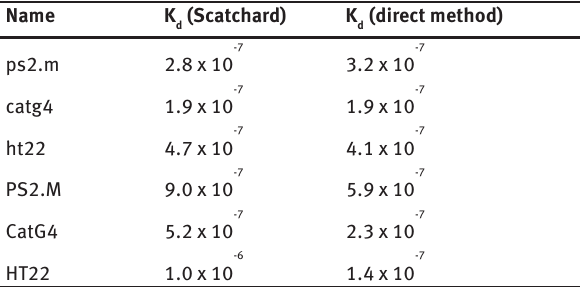
Table 3: Values of dissociation constants for G-quadruplex/hemin complexes determined using Scatchard analysis and “direct” approach method (eq. in Ref. 19).